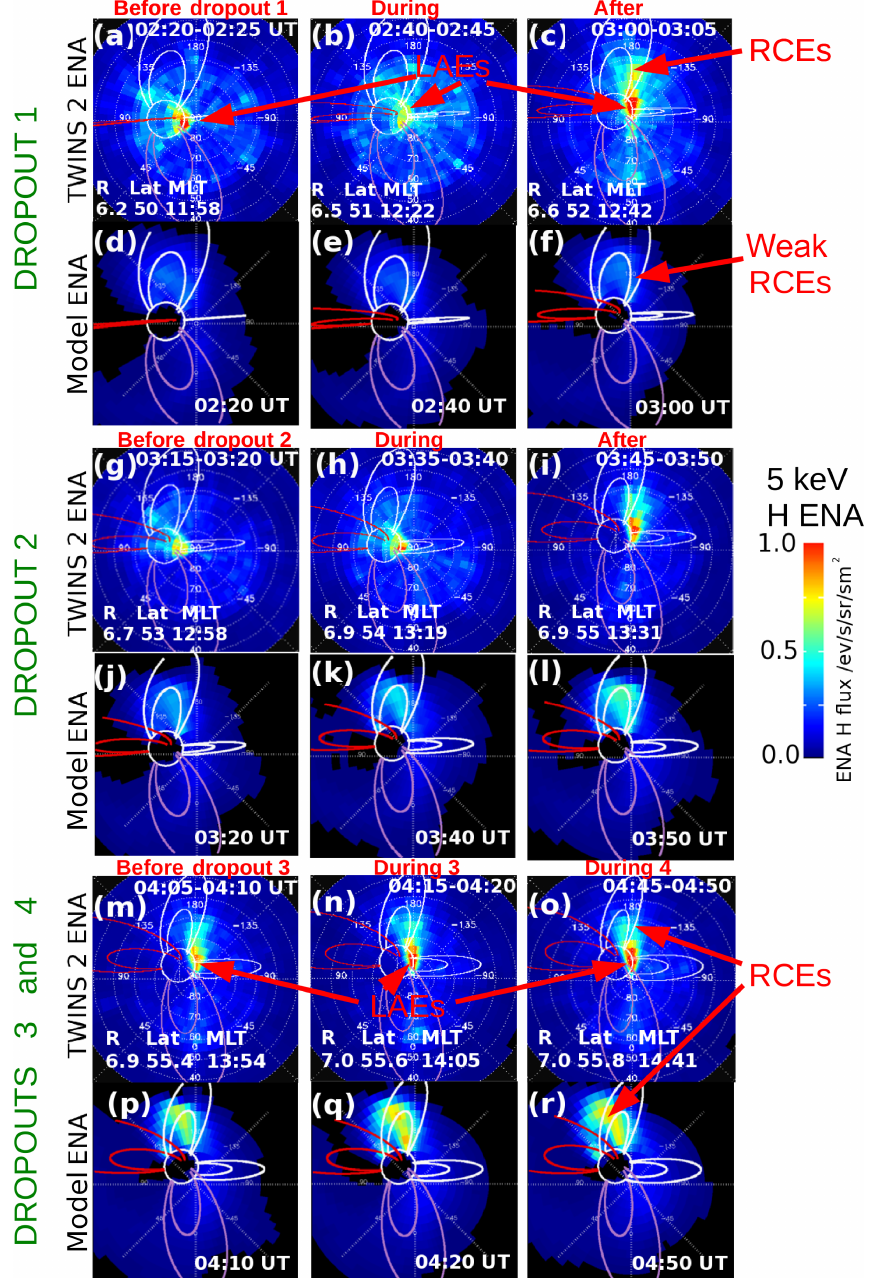
Figure 2. Dynamics of TWINS 2 ENA emissions and synthetic ENA images during the dropout intervals. Panels (a–c, g–i, m–o) show sky maps of TWINS 2 ENA differential fluxes in a fisheye projection for energy bin 5keV ± 2.5keV. Panels (d–f, j–l, p–r) show modeled ENA emissions plotted in the same projection. The field of view extends to 50 ◦ from the center of the image. The limb of the Earth and dipole magnetic field lines for L = 4 and 8 are drawn as guides. Noon (12:00MLT) and dusk (18:00MLT) field lines are colored red and purple, respectively. Low-altitude ENA emissions (LAEs) and high-altitude ring current emissions (RCEs) are marked by red arrows.